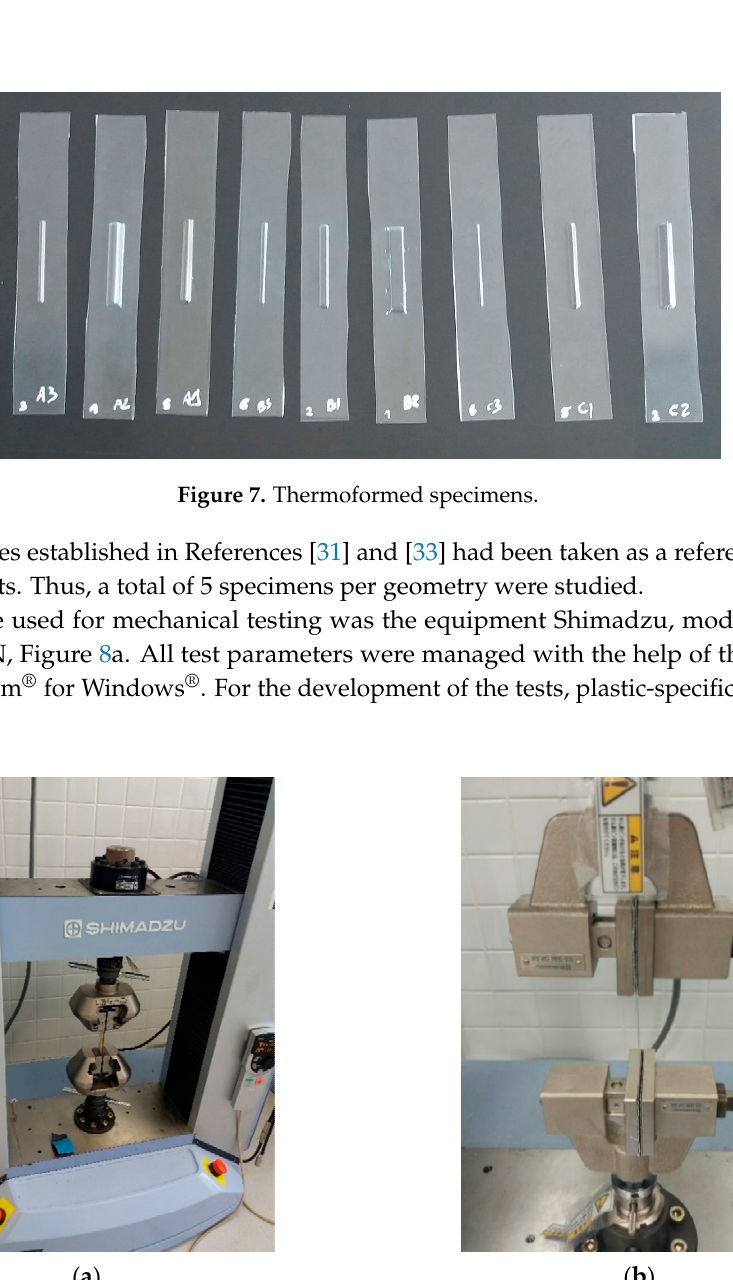
Figure 6. Dimensions of specimen according to standard [31].